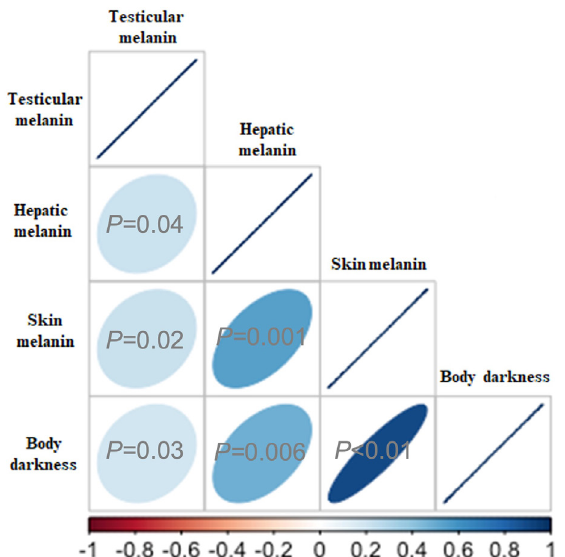
Figure 8. Correlogram showing the relationship among the variable-responses (melanophore, melanocytes and melanomacrophages) under effect of α-MSH at different exposure times (1, 3, 6, 12 and 24h). Color gradient indicates the strength of the correlation (r value) where blue circles show positive correlations. While shape shows significative correlation. All P -value are represented in figure